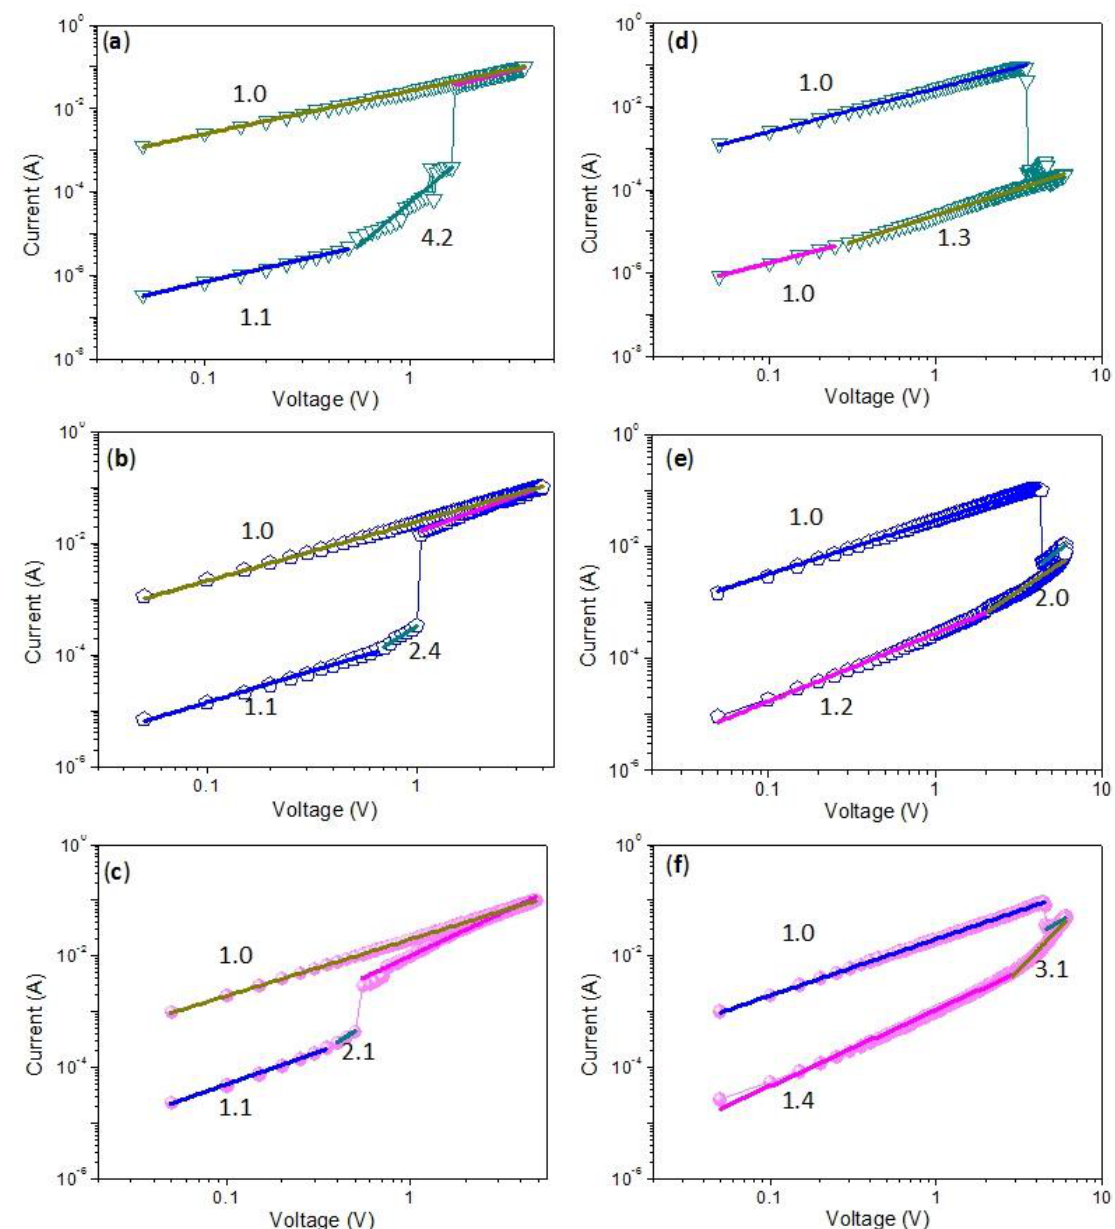
Figure 8. Fitting curves for the binary biomemristic behaviors with different content of GQDs 1 wt%, 3 wt% and 5 wt%, respectively, during the ( a – c ) SET and ( d – f ) RESET process.